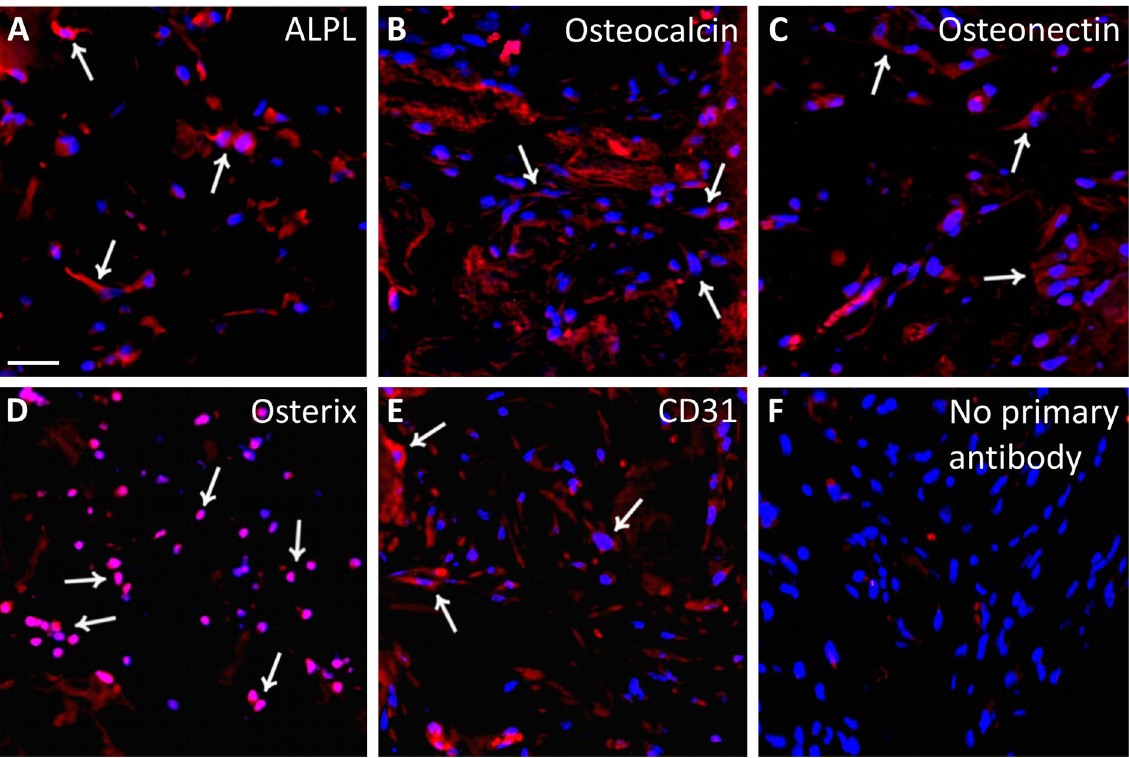
Figure 8. Panel of fluorescence microscope images showing typical examples of ALPL ( A ), Osteocalcin ( B ), Osteonectin ( C ), Osterix ( D ) and CD31 ( E ) expression (red fluorescence). Arrows indicates some positive cells. A negative control obtained by omitting the primary antibody shows the absence of any fluorescent signal. Nuclei have been stained with DAPI (blue). Scale bar: 40 μ